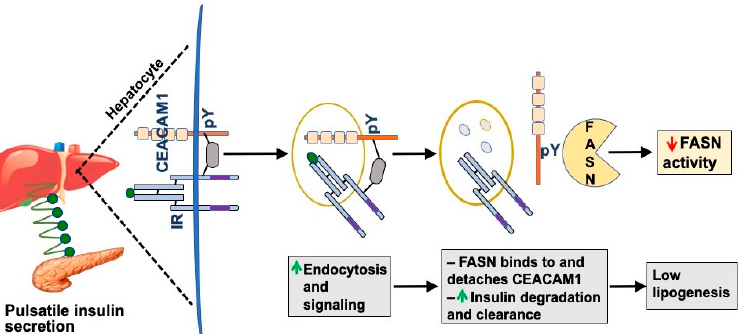
Figure 1. CEACAM1 phosphorylation induces hepatic insulin clearance. In response to pulses of secreted insulin from pancreatic β -cells (green circles), the insulin receptor (IR) tyrosine kinase on the surface membrane of hepatocytes is activated. This phosphorylates CEACAM1 on the species conserved tyrosine (pY) 488 residue, an event that mediates the formation of a stable insulin – IR – CEACAM1 complex to increase the rate of insulin endocytosis and targeting to its degradation process (green upward arrow). Fatty acid synthase (FASN) binds to pY488 of CEACAM1 to cause its detachment and facilitate the separation of insulin from its receptor to undergo degradation in the acidic milieu of late endosomes (grey circles). FASN binding to phosphorylated CEACAM1 also causes repression of FASN activity (red downward arrow), thus maintaining low lipogenesis in the liver despite the higher level of insulin in the portal vein than systemic circulation. Not shown in this schematic diagram, IR recycles back to the surface membrane.